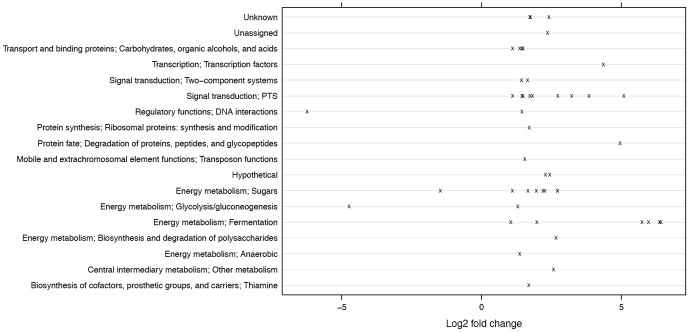
Distribution of functional classes of differentially expressed genes between UA159 and TW1 growing on glucose.The x-axis represents the log2 values of the fold of change in expression (TW1/UA159).